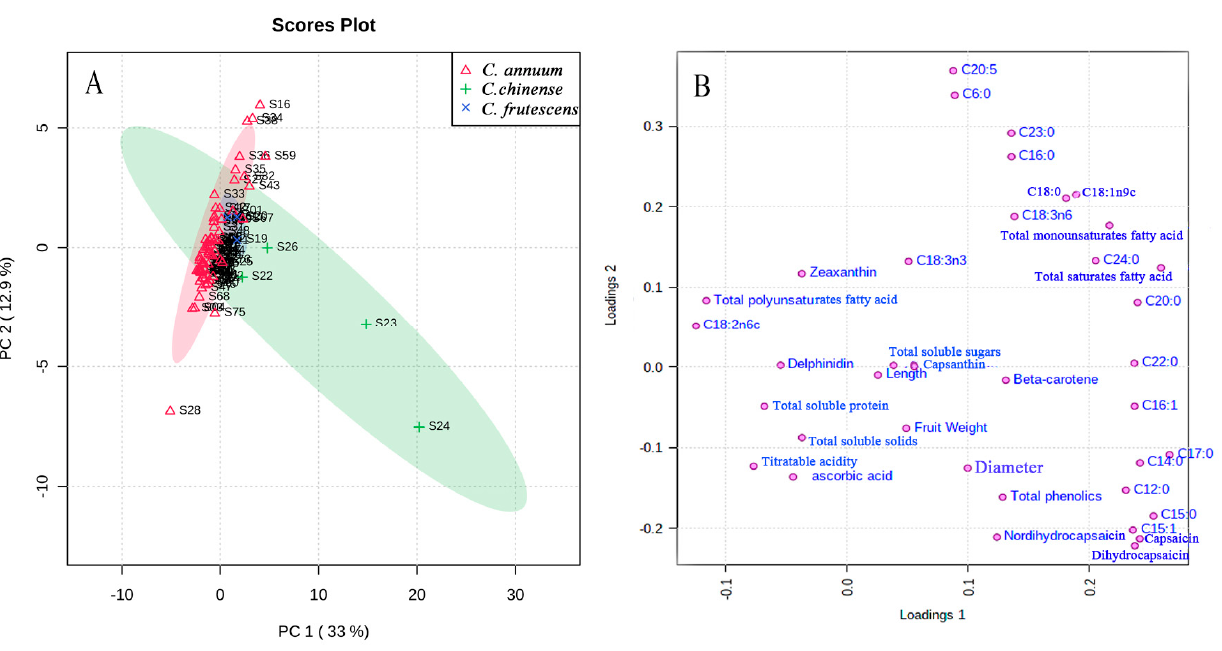
Figure 3. Principal component analysis of quality indicators of 75 pepper germplasm resources. ( A ) The PCA score plot in the space of the first 2 PCs explaining 45.9% of the total variance, and ( B ) the corresponding loadings plot. Sample number as shown in Table 1 .